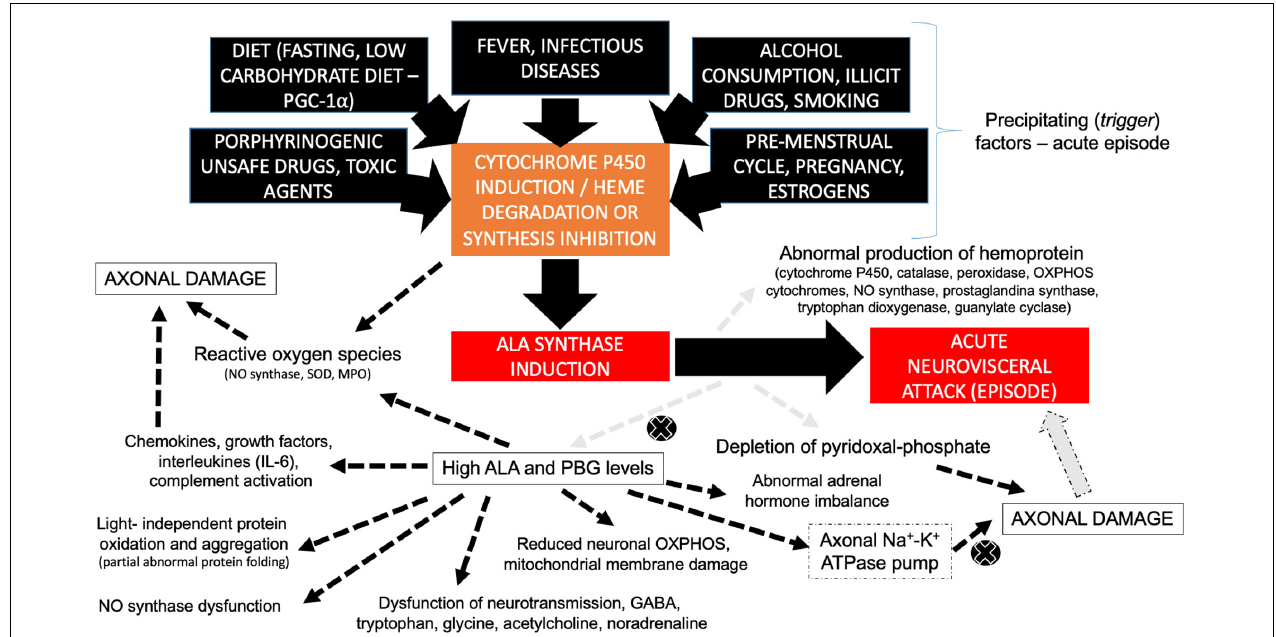
FIGURE 3 | Diagram disclosing the different pathophysiological mechanisms involved with axonal damage in AHP during acute neurovisceral attacks. Different trigger (precipitating) factors lead to cytochrome P450 induction, heme group degradation, and/or the inhibition of heme synthesis, giving rise to ALA synthase induction and the secondary formation of high contents of neurotoxic ALA and PBG metabolites, leading to acute neurovisceral attack. ALA synthase induction is also associated with abnormal production of hemoprotein (related to several of the multisystemic signs and symptoms of AHP) and secondary depletion of pyridoxal-phosphate (leading to potentially reversible axonal damage). Legend, ALA, delta-aminolevulinic acid; GABA, gamma-aminobutyric acid; IL-6, interleukin-6; MPO, myeloperoxidase; NO, nitric oxide; OXPHOS, oxidative phosphorylation; PBG, porphobilinogen; PGC-1a, peroxisome proliferator-activated receptor-gamma coactivator-1 alpha; SOD, superoxide